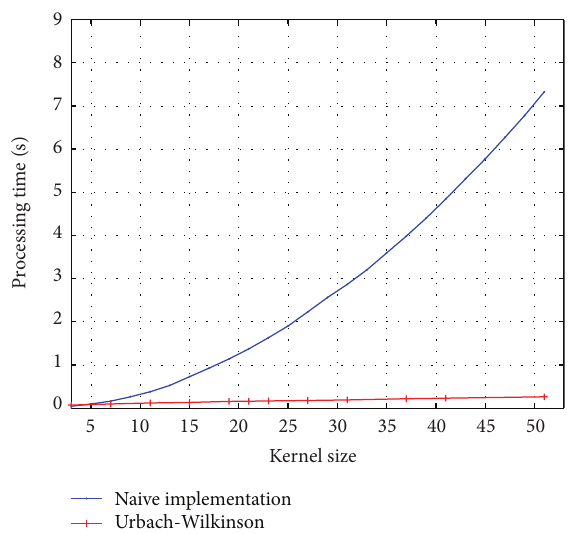
Figure 7: Processing time for the running max/min filters on an 2160×1440 input image with different kernel sizes for a straightfor- ward implementation and the Urbach-Wilkinson algorithm.